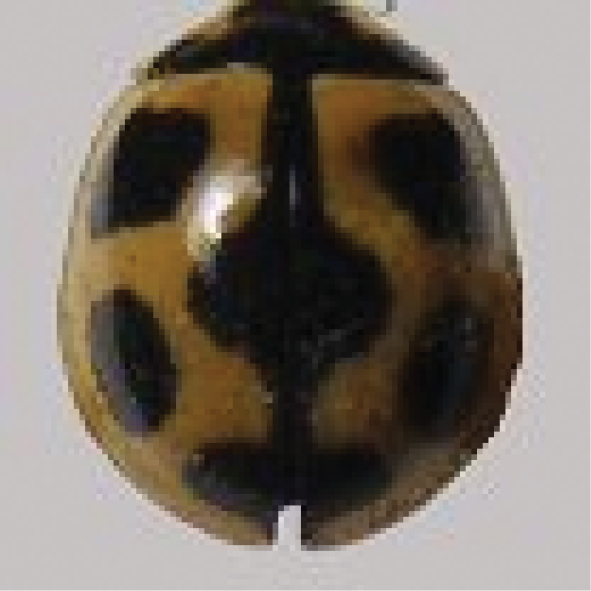
Oenopiamimica Weise.